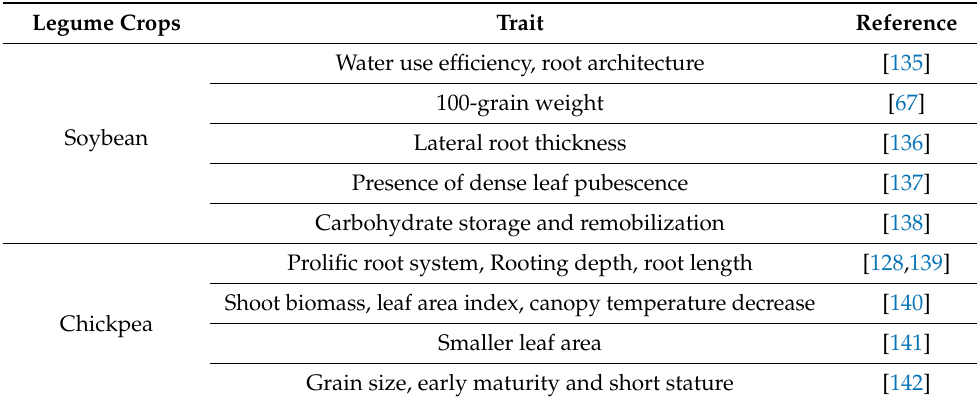
Table 2. Potential traits / characters for screening legumes for drought